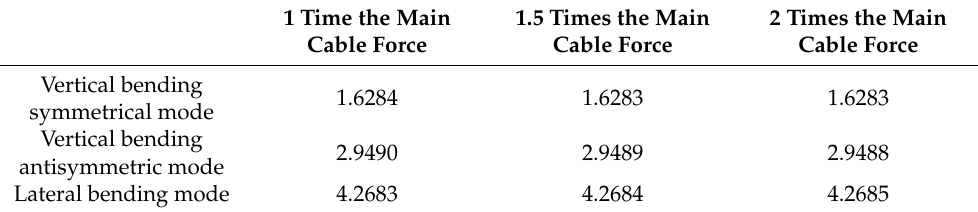
Table 2. Frequency calculation of the main cable force variation